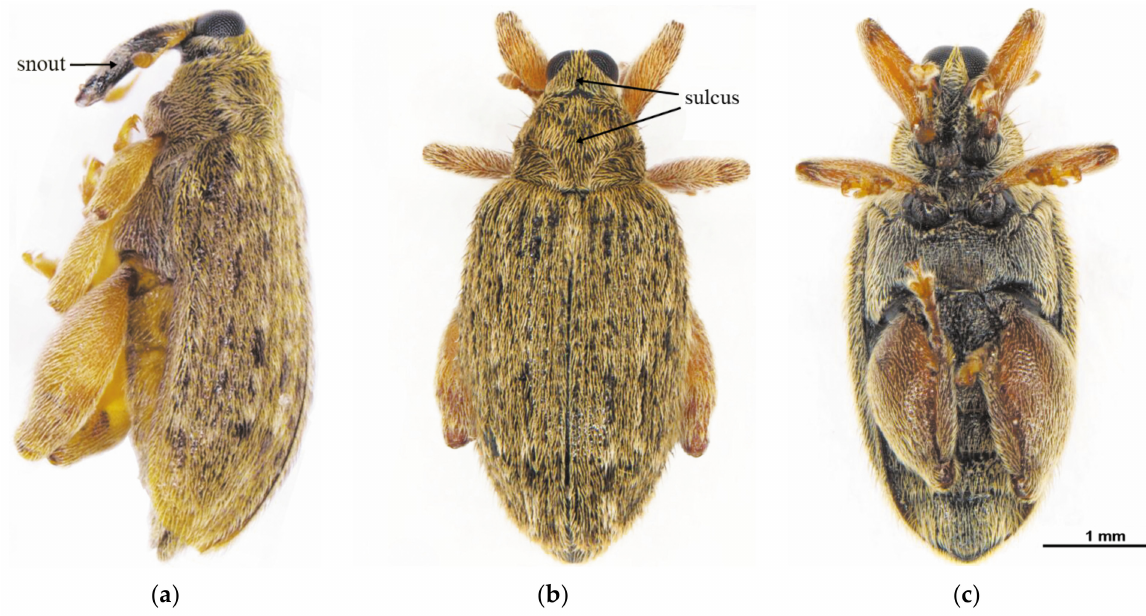
Figure 4. Adult of Rhynchaenus maculosus . ( a ) Lateral view; ( b ) dorsal view; ( c ) ventral